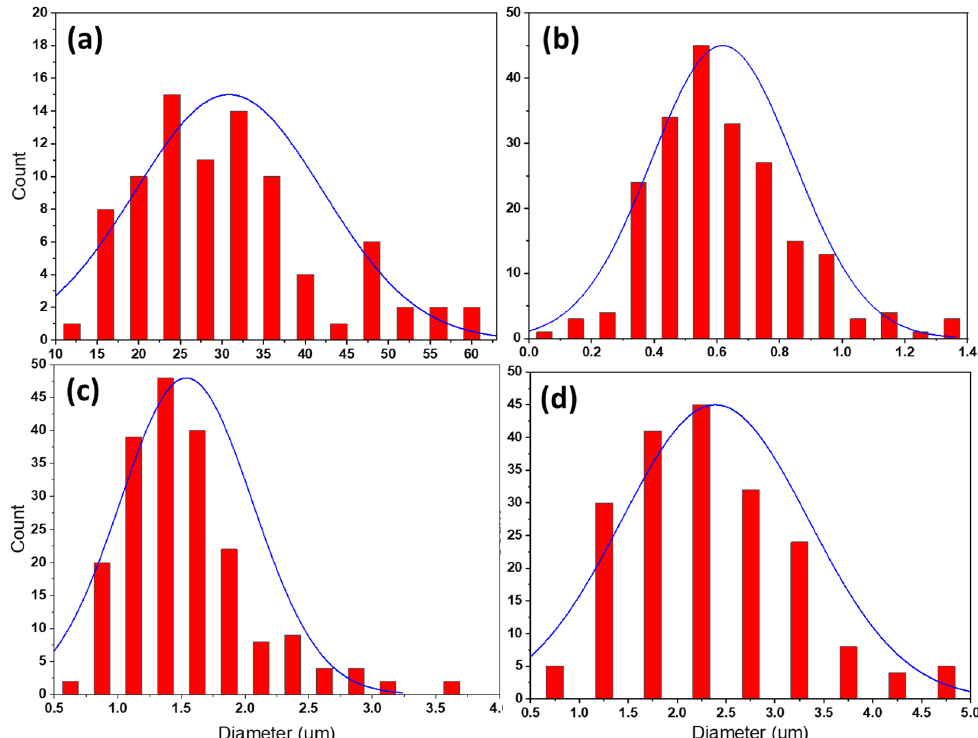
Figure 11. Grain size distribution histograms of ( a ) as-cast A356 alloy and AMPs deposited at a constant rotation speed of 1200 rpm and different feeding speeds of ( b ) 3 mm/min, ( c ) 4 mm/min, and ( d ) 5 mm/min.